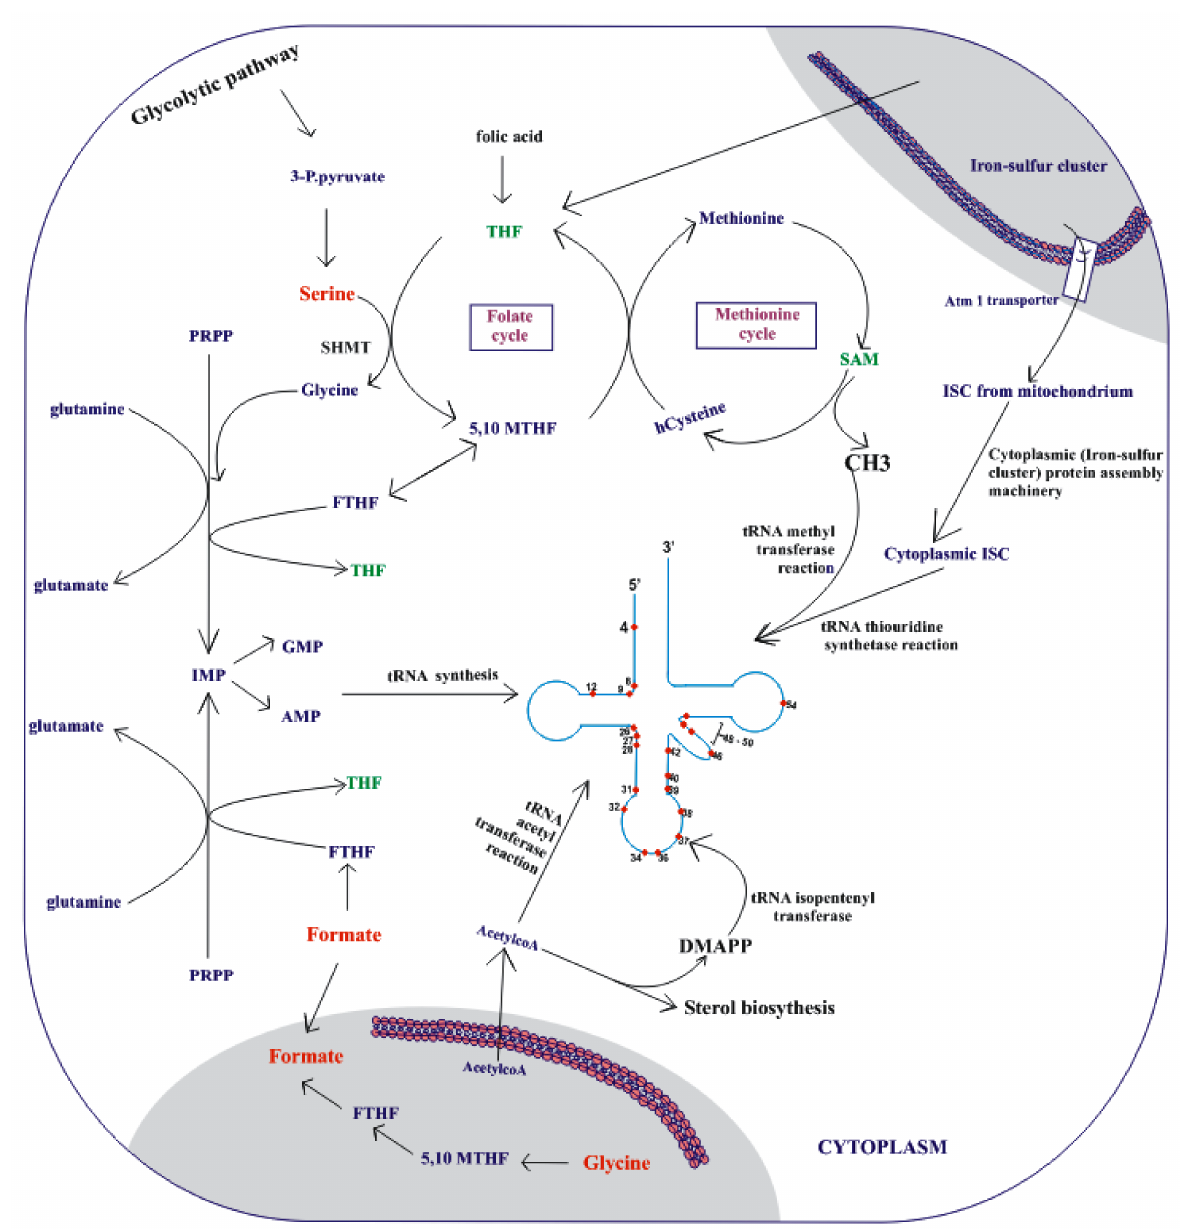
Figure 3. The metabolic pathways that provide precursors necessary for the tRNA modifying en- zymes in eukaryotes. The mitochondrion metabolic activity plays a vital role in tRNA modification. The single-carbon metabolism in the mitochondrion maintains the appropriate cytoplasmic pool of tetrahydrofolate (THF). The folate cycle cross-talks with the methionine cycle in a highly depen- dent manner, thereby providing SAM, a methyl donor for tRNA methyltransferase reaction. The mitochondria also supply an iron–sulfur (Fe/S) cluster that is transported via the Atm1 transporter into the cytosol. The cytoplasmic iron–sulfur protein assembly machinery produces the cytoplasmic iron–sulfur cluster that is essential for tRNA thiolation. In addition, intermediary metabolic pathways in the mitochondria usually produce acetyl-CoA, which serves as a donor of acetyl moiety for the tRNA isopentenylation pathway and most acetyl transferase reactions, including tRNA acetylation. The glycolytic pathway serves as a major source of energy for tRNA synthesis. Overall, the modi- fication hotspots of tRNA are also shown, including their positions. (SAM: S-adenosylmethionine; 3-P. pyruvate: 3-phosphohydroxy pyruvate; ISC: iron–sulfur cluster; 5,10 MTHF: N , N -methylene tetrahydrofolate; FTHF: 10-formyltetrahydrofolate; SHMT: serine hydroxymethyltransferase; PRPP: phosphoribosyl pyrophosphate; DMAPP: